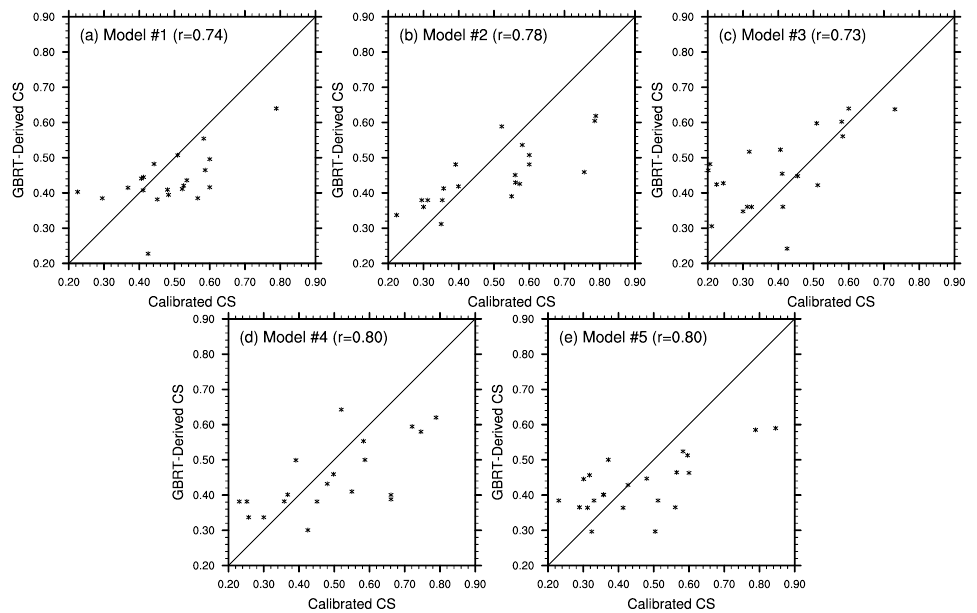
Figure 6. Scatter plot showing comparison between calibrated and GBRT-derived CS of five different GBRT models using data in testing groups. ( a ): Model #1; ( b ): Model #2; ( c ): Model #3; ( d ): Model #4; ( e ): Model #5.